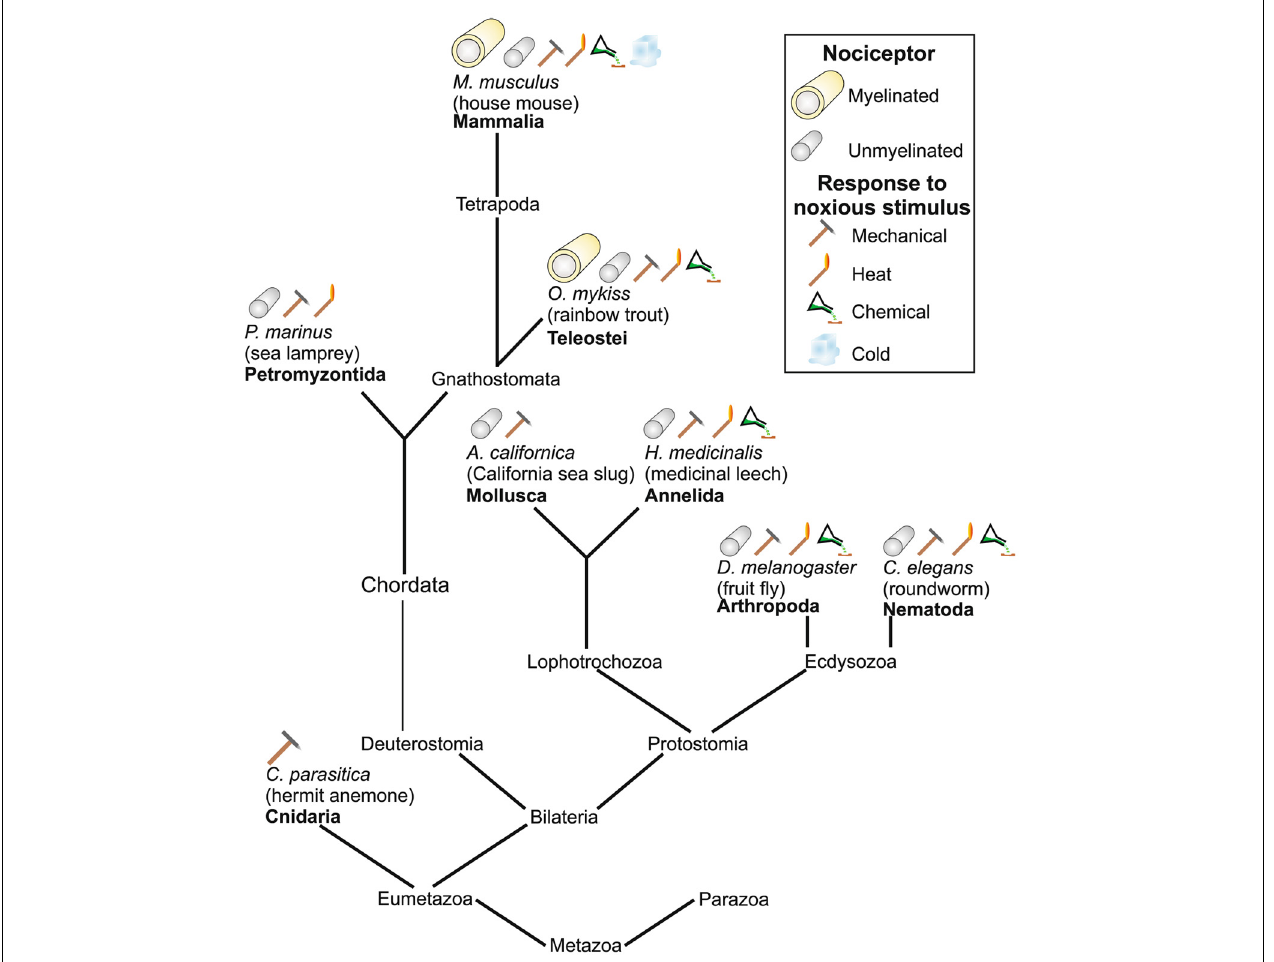
FIGURE 4 | Various types of nociceptors found across different species. From Figure 4 in Smith and Lewin (2009) Springer. Reprinted with kind permission from Springer Science + Business Media